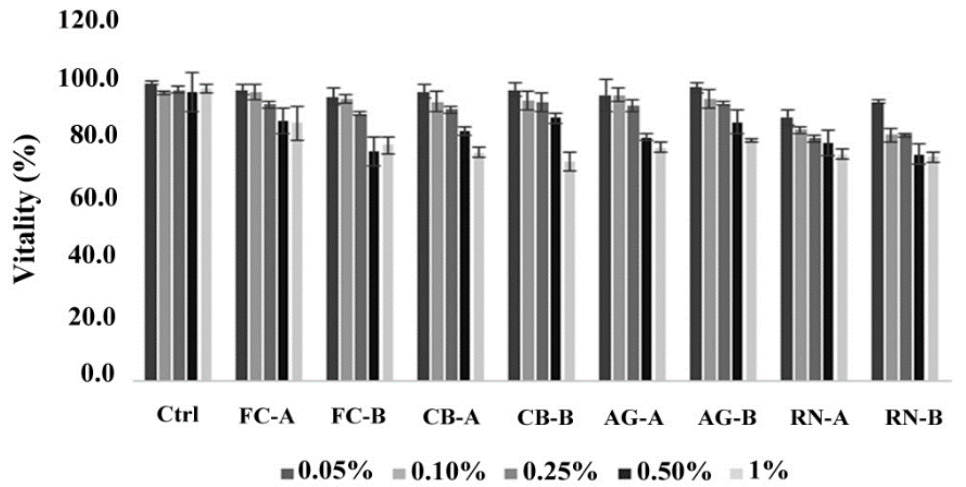
Figure 2. Cytotoxicity assays performed with a Cell Titer Blue assay on 3T3 fibroblasts at 24 h after cell synchronization. The error bar indicates the standard deviation.